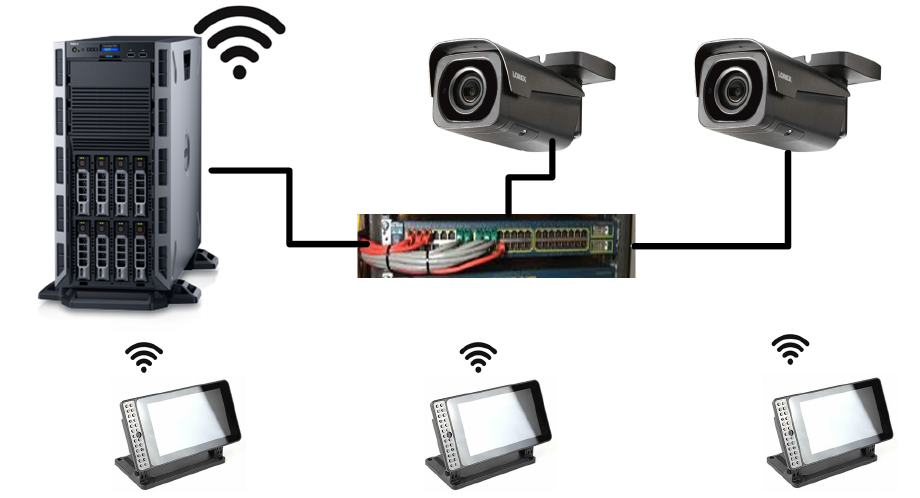
Figure 7. The proposed biometric sensor network.